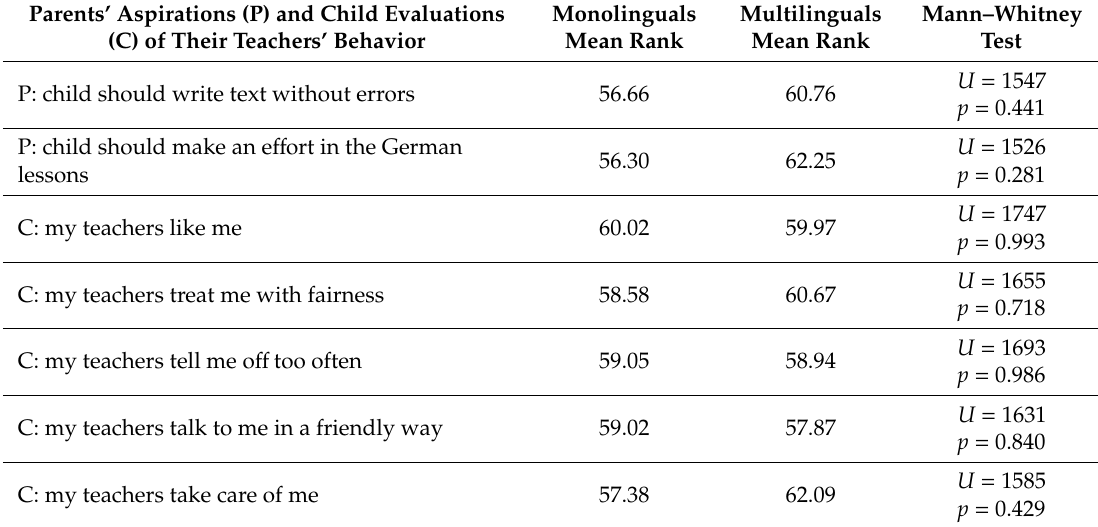
Table 1. Mean ranks per group (P: mono- and multilingual parents; C: mono- and multilingual third-graders) for parental aspirations towards educational achievements (e.g., spelling) and children’s willingness to learn (e.g., German language) (P, upper part) and for children’s evaluations of their teachers’ behavior towards them (C, lower part) based on questionnaire responses by parents or children. Parents’ Aspirations (P) and Child Evaluations Monolinguals Multilinguals Mann–Whitney (C) of Their Teachers’ Behavior Mean Rank Mean Rank